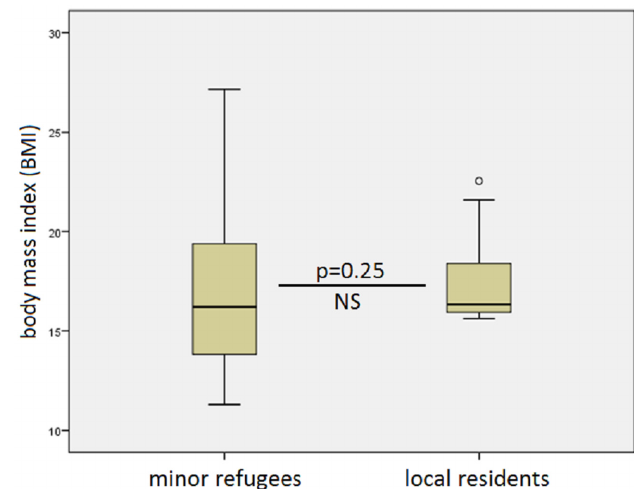
Figure 2. Comparison of body mass index (BMI) between refugees (left) and locally residing in-house patients. While the mean values were similar at 16.2 versus 16.3 ( p = 0.25, nonsignificant (NS)), the range was greater in the minor refugee group.